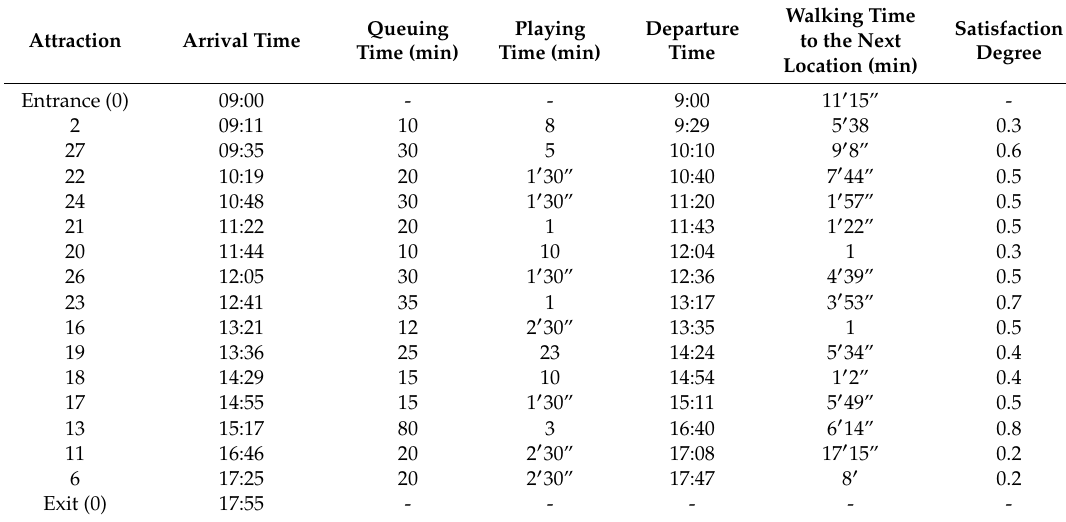
Table 3. Results of the satisfaction route with PGA (28 attractions).